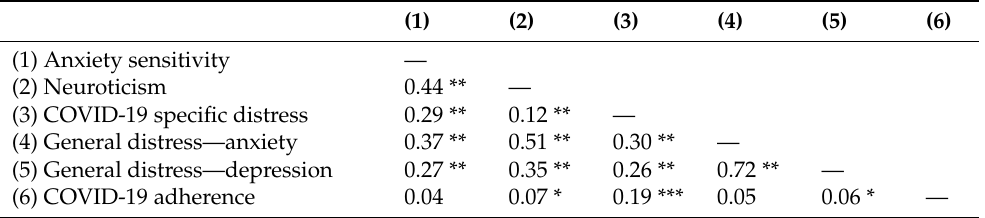
Table 2. Correlations between independent and dependent